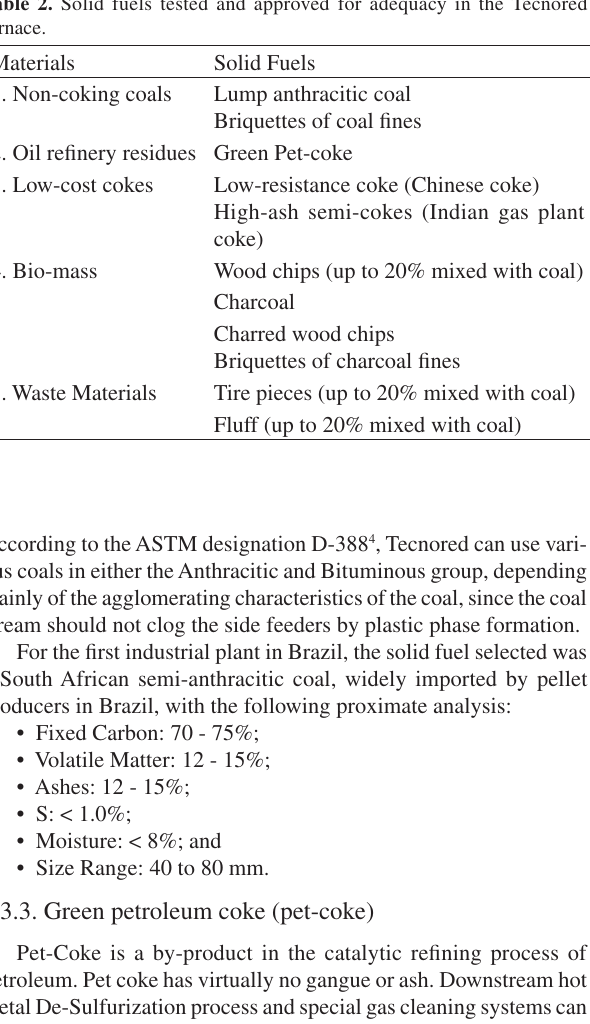
Table 2. Solid fuels tested and approved for adequacy in the Tecnored furnace. Materials